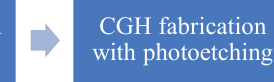
ff -axis aspheric